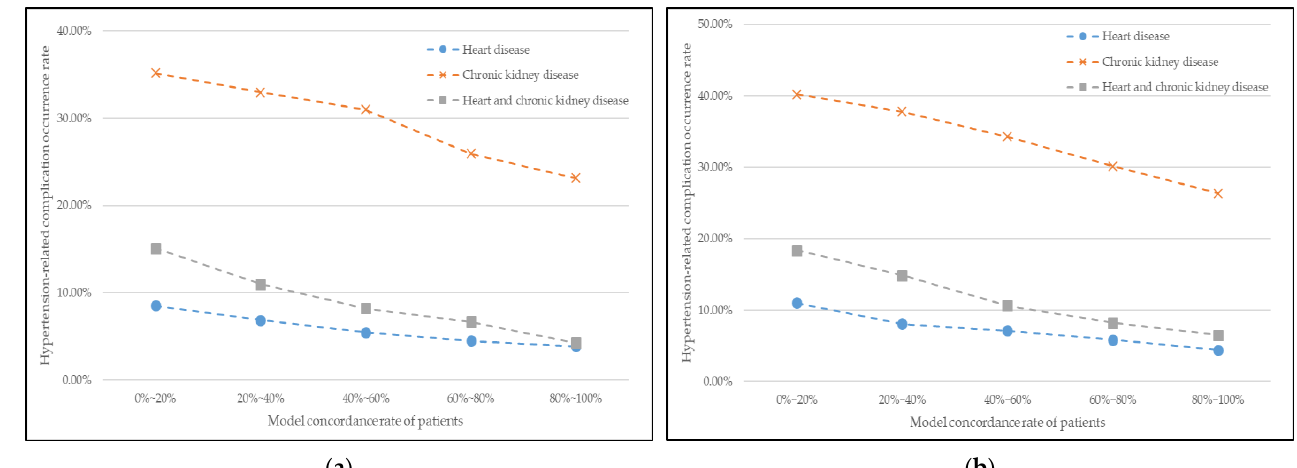
Figure 4. Relationship between patients’ model concordance rate and complication occurrence for ( a ) male patients and ( b ) female patients.